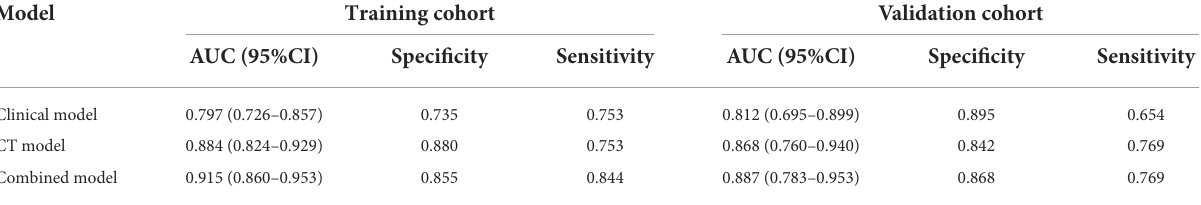
TABLE 3 Predictive performance of clinical model, CT model, and combined